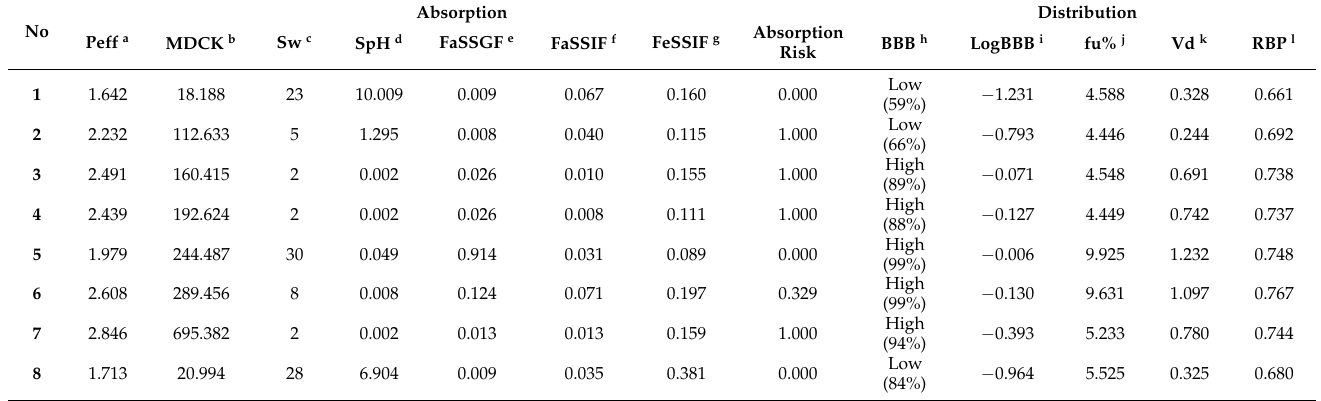
Table 7. Absorption and distribution properties for the examined compounds 1 – 17